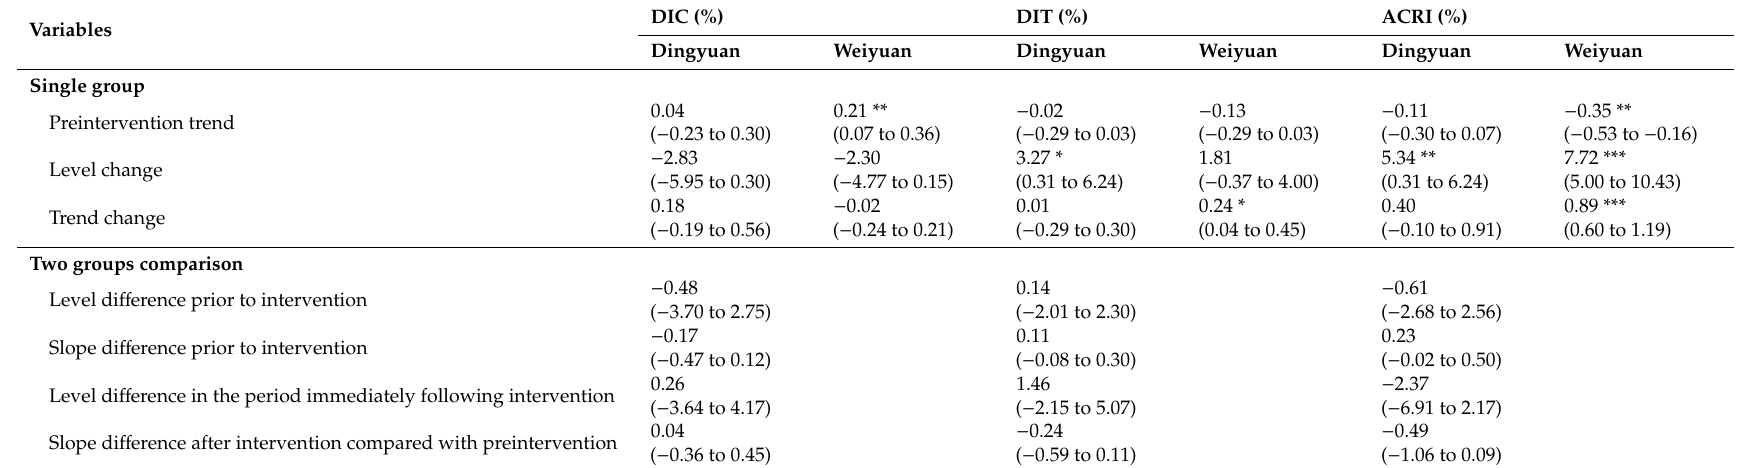
Table 3. Estimated changes and di ff erence in level and trend of indicators of single- and two-groups